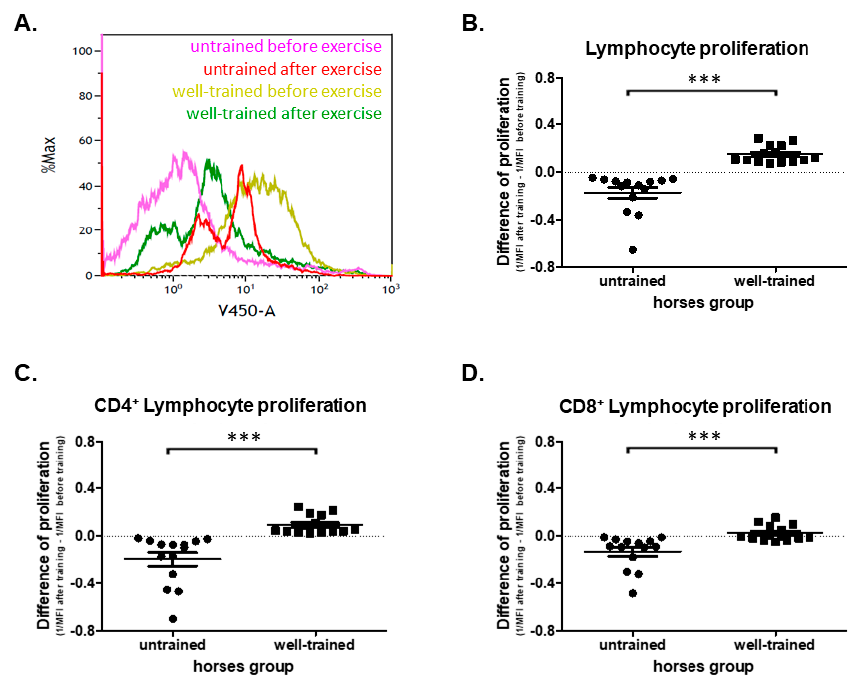
Figure 2. ( A ) Representative histogram showing T lymphocyte proliferation obtained before and after exercise from untrained and well-trained horses. The graph shows total ( B ), CD4 + ( C ), and CD8 + ( D ) lymphocyte proliferation. The results are presented as the mean ± SEM. Significance levels are: *** p < 0.001.